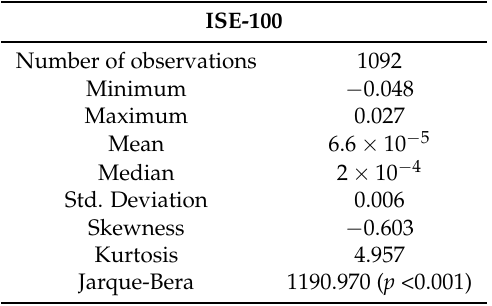
Table 1. Summary statistics for the ISE-100 index.